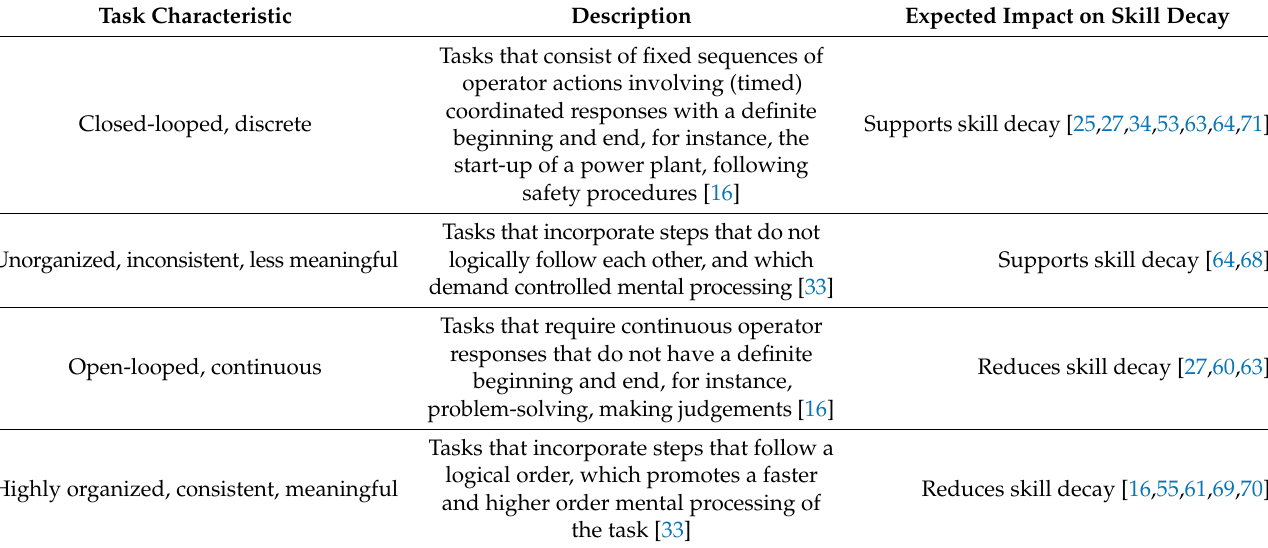
Table 4. Task characteristics and their expected impacts on skill